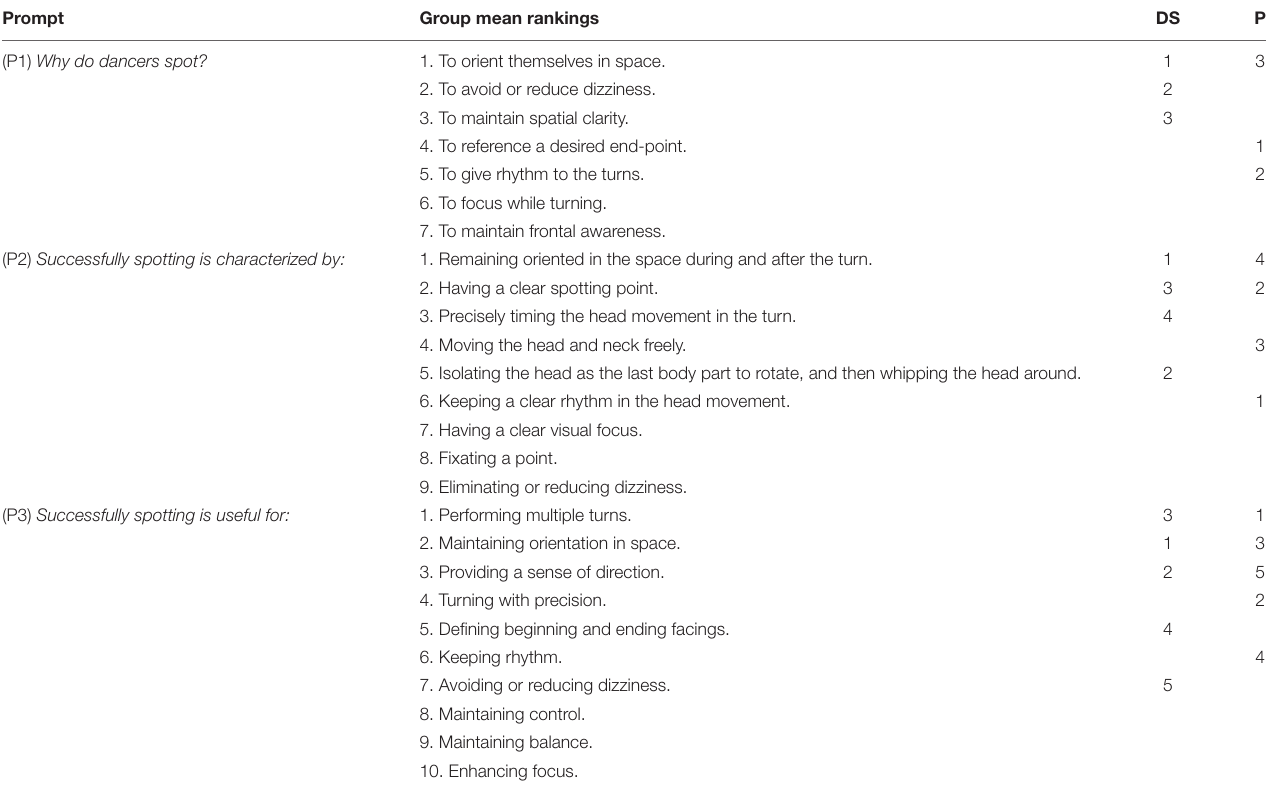
TABLE 2 | Group mean rankings of relevant items and top-half rankings of dance scientists (DS) and practitioners (P) subgroupings. Prompt Group mean rankings DS